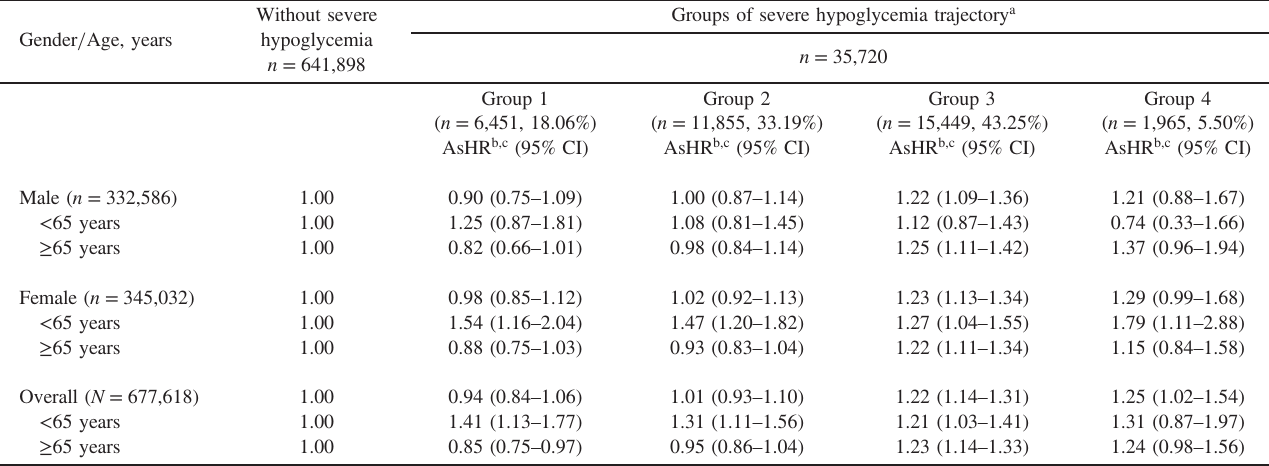
Table 3. Covariate-adjusted subdistribution hazard ratios of dementia diagnosis in relation to groups of severe hypoglycemia incidence trajectory for patients with type 2